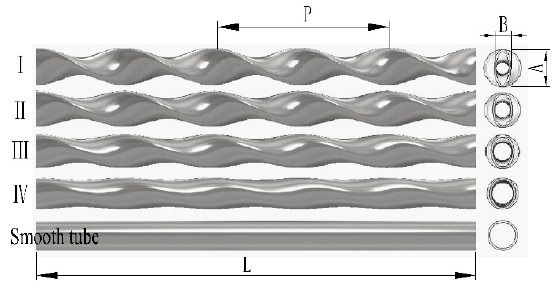
Figure 2. Heat exchanger test prototype.